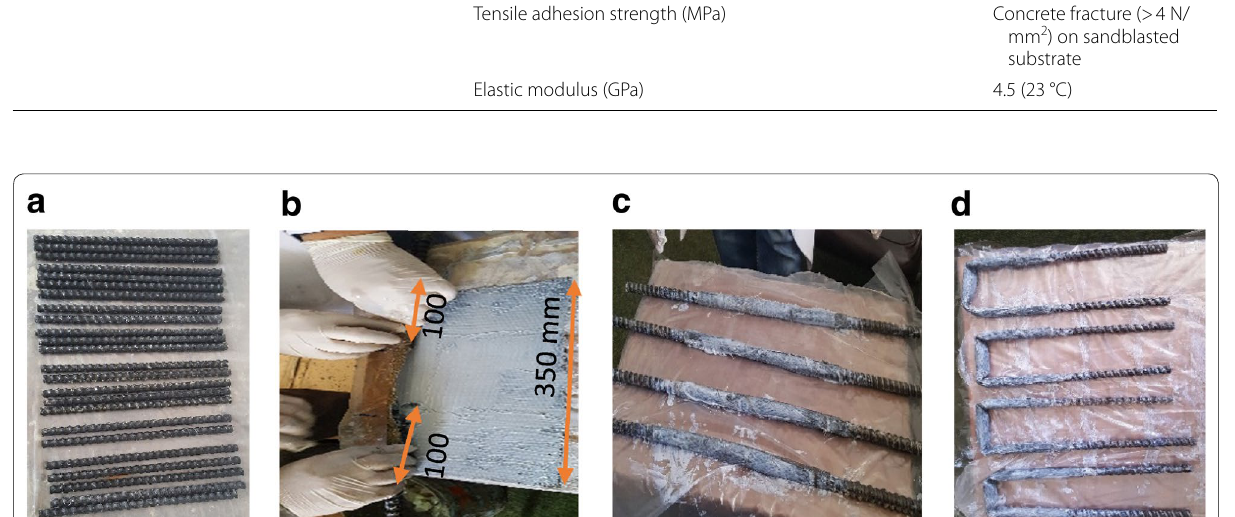
Fig. 4 Fabrication process of U-shaped BFRP stirrups: a BFRP bars; b impregnated BFRP sheet during wrapping; c after wrapping the BFRP sheets around the bar ends; and d the final shape of U-shaped hybrid BFRP